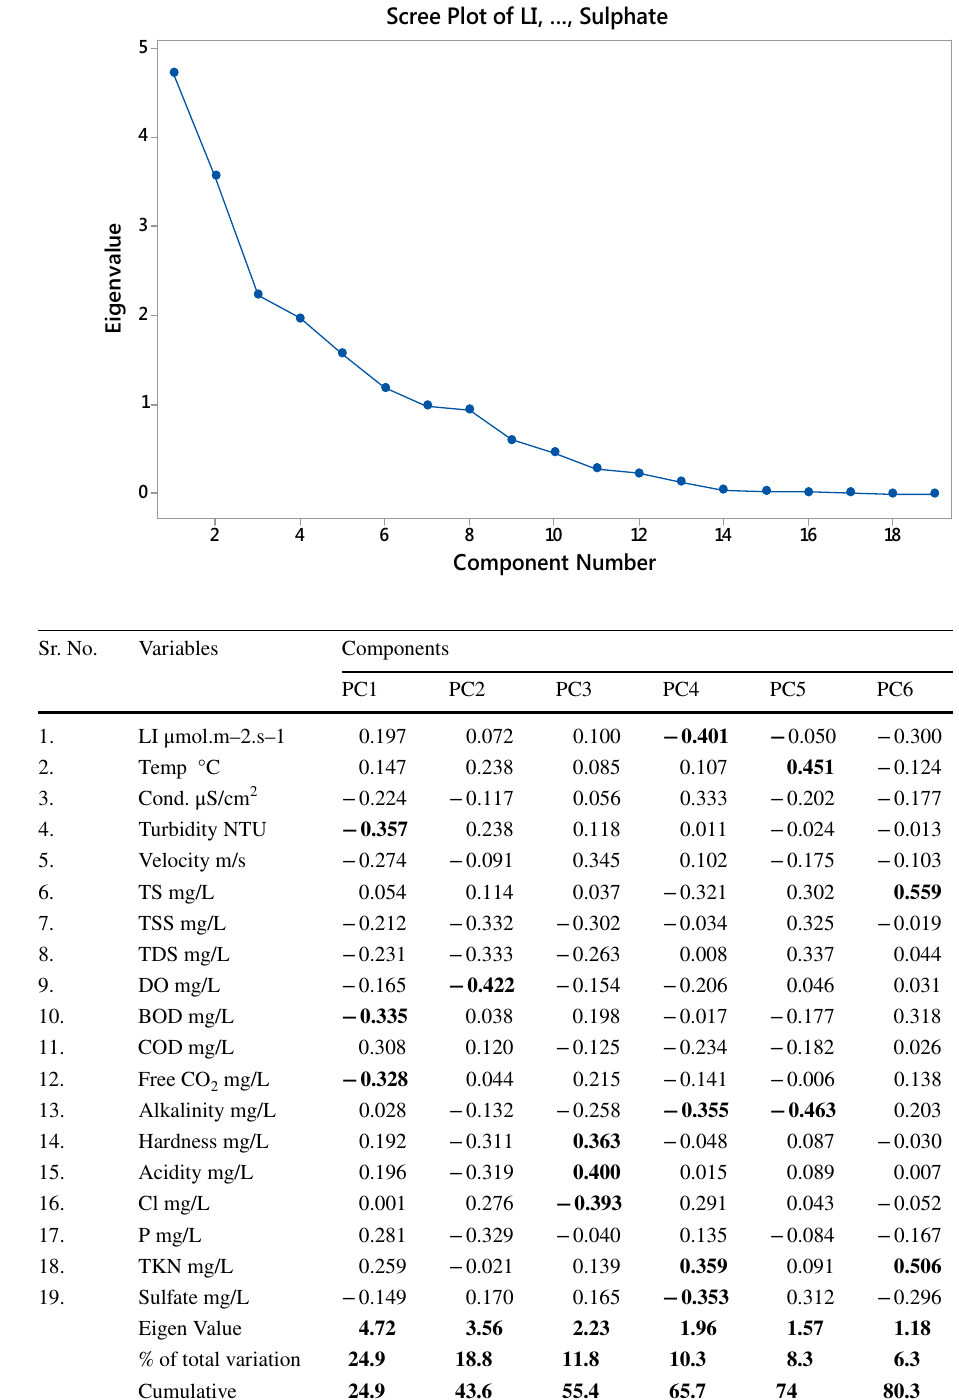
Fig. 2 Screen plot of various PCs 181614121086425